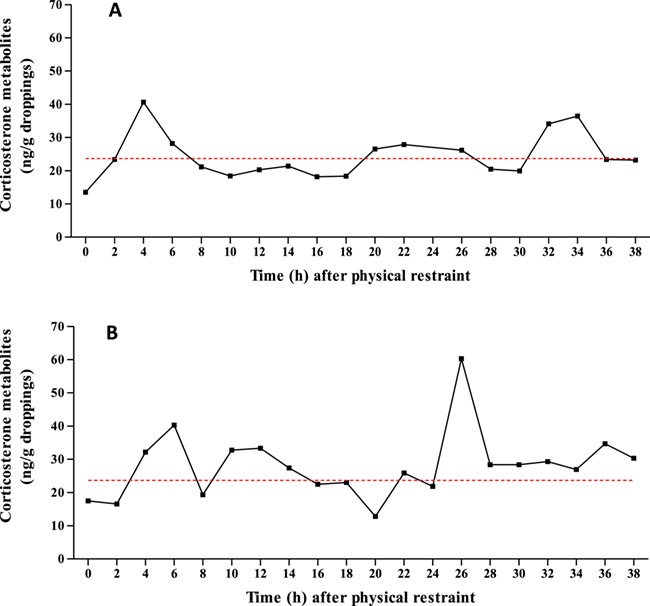
Urofaecal CM concentrations (ng/g dry matter) profile from a physical restraint procedure (h 0) in (A) a female and (B) a male Blue-fronted parrot (A. aestiva) using a corticosterone EIA. Dashed line represents the mean of pre-restraint uGCM concentration (ng/g dry matter).